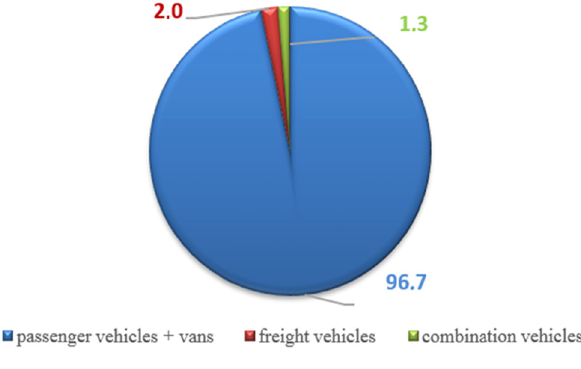
Figure 5: The ratio of the individual vehicles categories ( 1st survey )